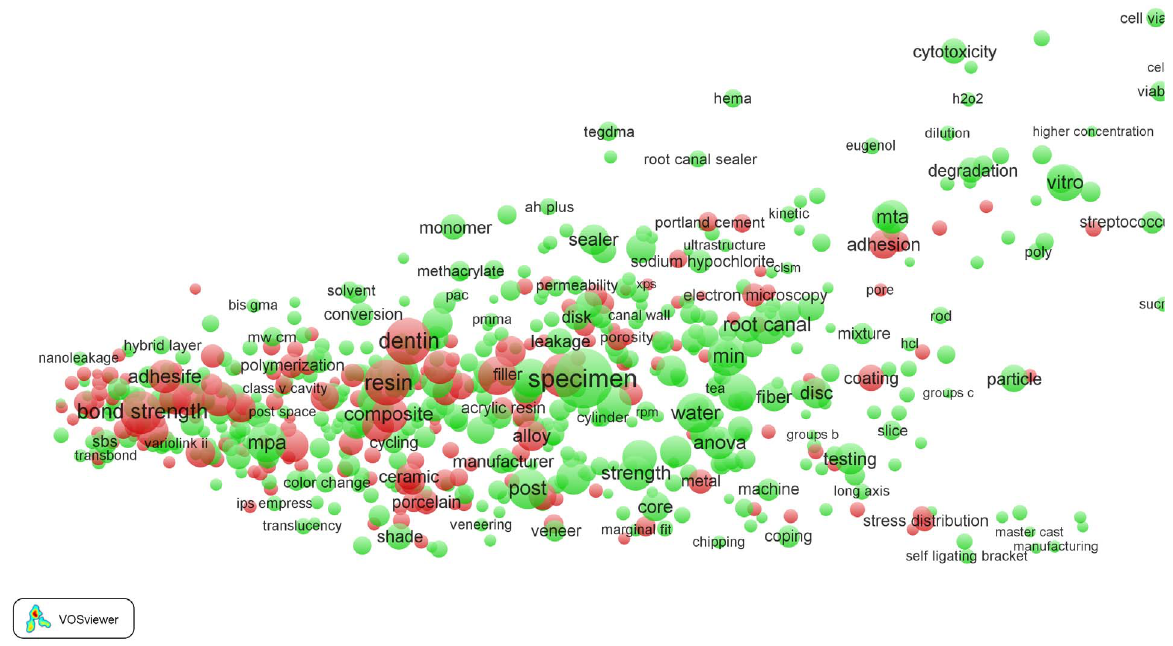
Figure 6. Term map of the Dentistry field after zooming in into the clinical subfield.